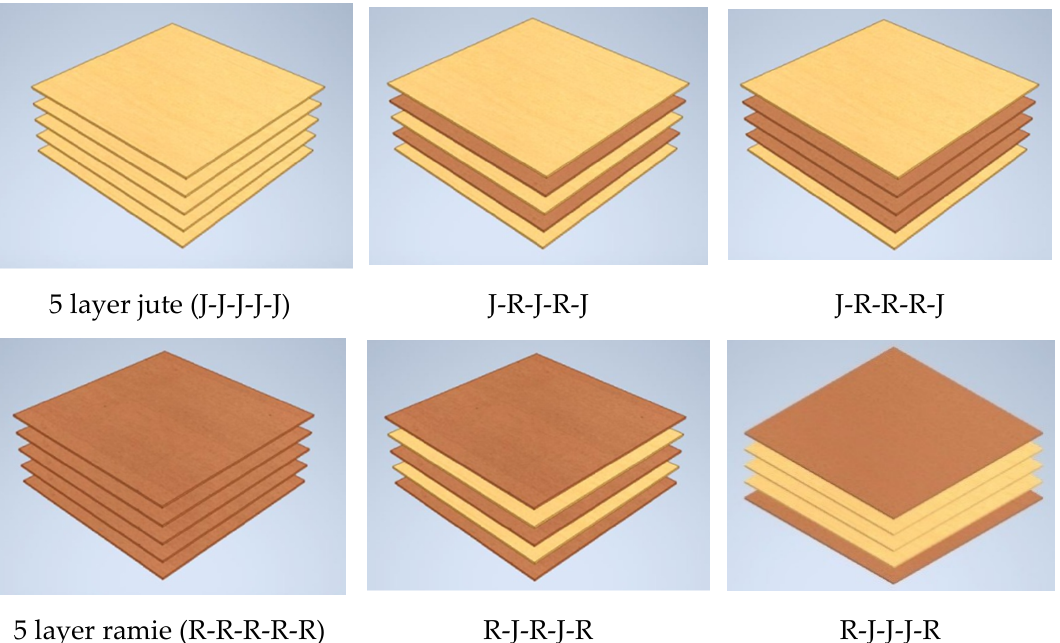
Figure 3. Schematic of stacking sequence of hybrid jute–ramie composites.